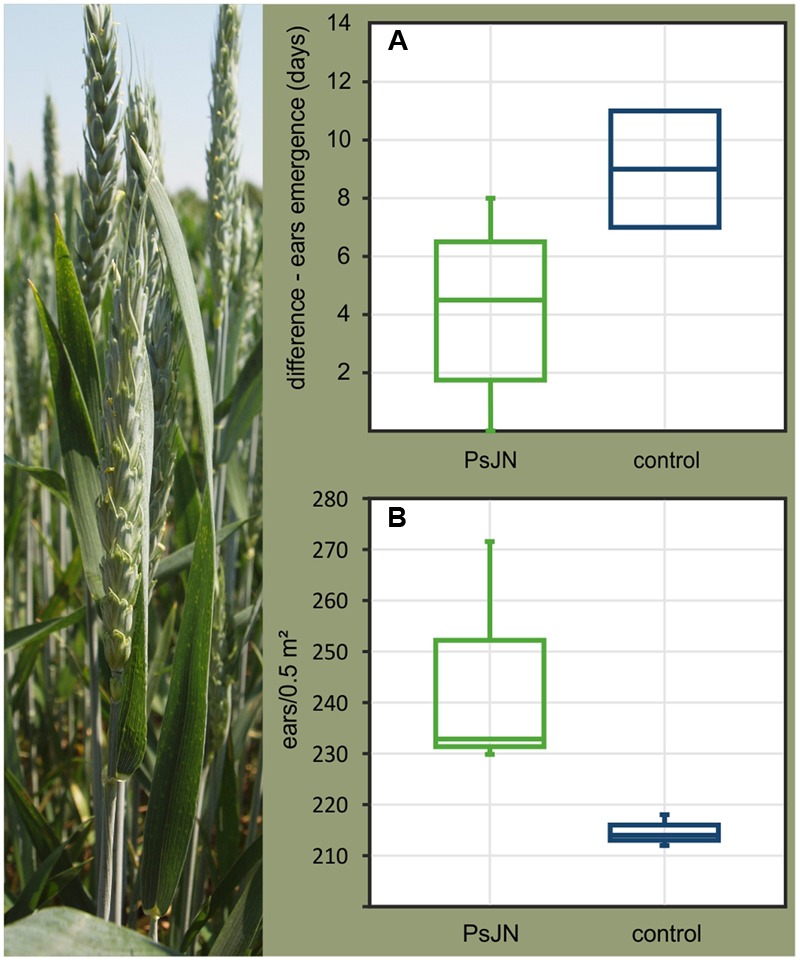
Differences in ear emergence times between wheat plants (Triticum aestivum cv. Trappe) growing from seeds colonized by P. phytofirmans PsJN and control seeds (A) observed in greenhouse pot experiments and in the field (B). (A) The different time points of flowering in control and PsJN-colonized plants is shown. (B) A significantly higher number of ears per square meter in the plots was observed for PsJN-plants (n = 722) as compared to control plants (n = 644) (F-test; p = 0.018). All wheat plants tested belonged to the F1 generation, derived from parent plants which were sprayed with a suspension of P. phytofirmans PsJN or sterile buffer (control).